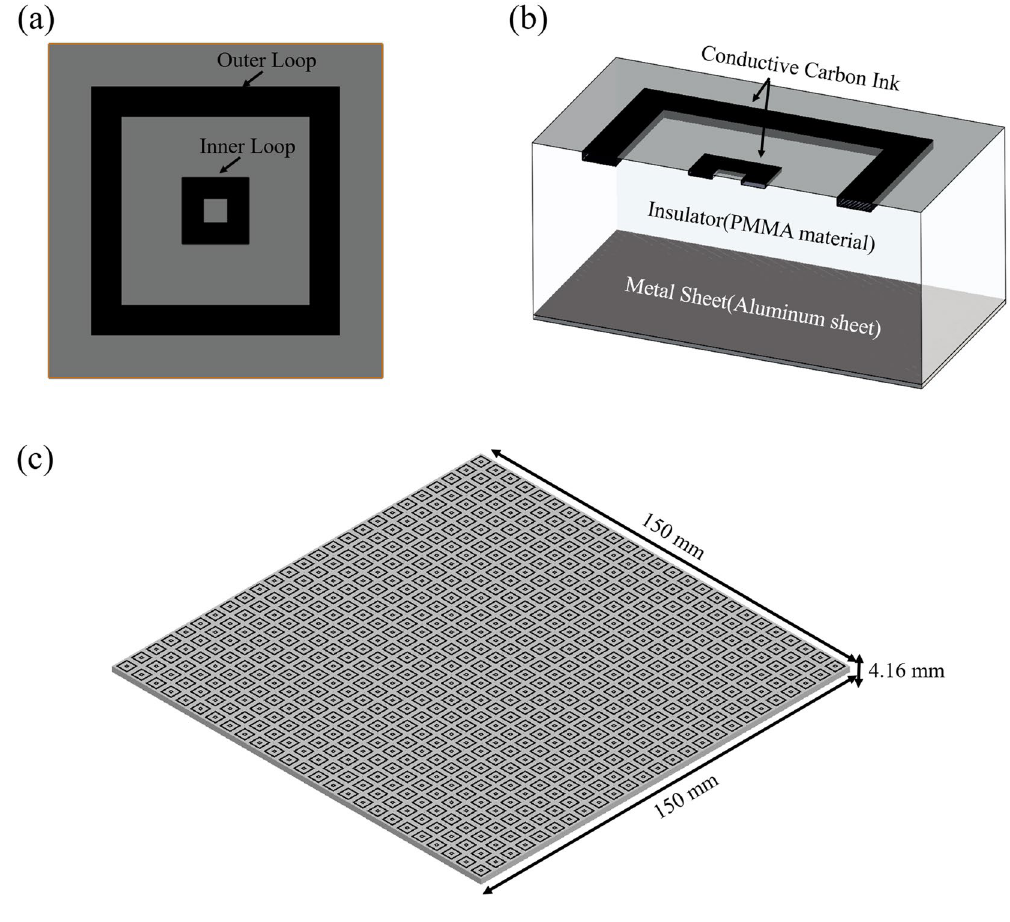
Figure 1. Structural design of the microwave absorber with resistive double square loop arrays. ( a ) Top view of unit-cell, ( b ) cross-section of the unit-cell, ( c ) full structure of the microwave absorber.